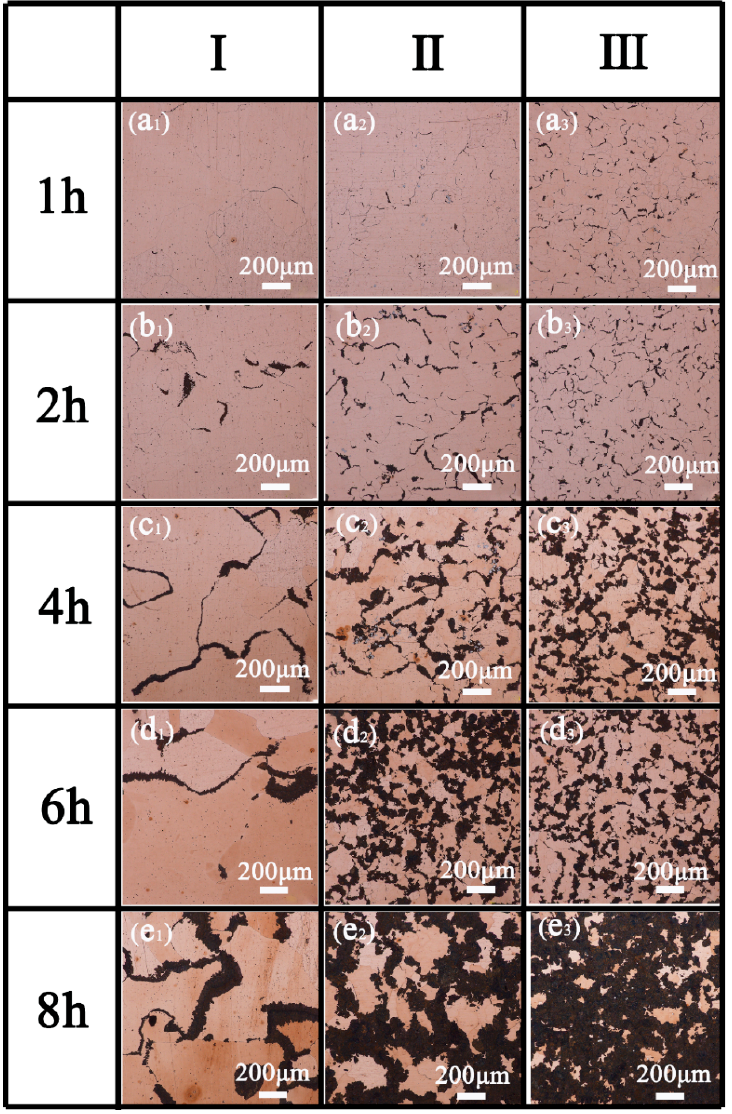
Figure 10. Metallographic microstructure of Cu–15Ni–8Sn–xMo (x = 0.3, 0.9, 1.5 wt.%) alloys aged at 400 ◦ C for 1–8 h: ( a 1 – e 1 ) x = 0.3, ( a 2 – e 2 ) x = 0.9, ( a 3 – e 3 ) x = 1.5